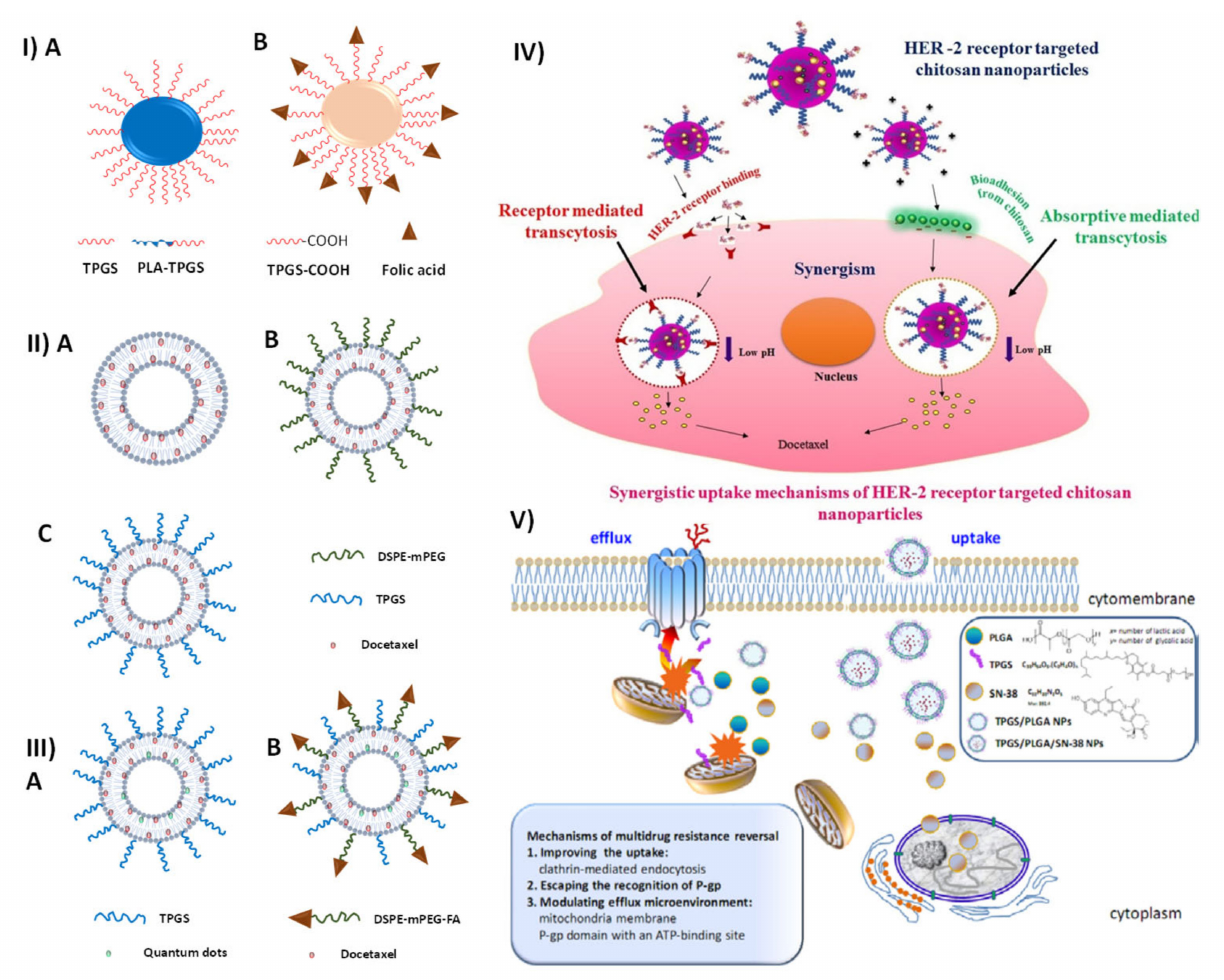
Figure 4. ( I ) ( A ) TPGS-emulsified PLA-TPGS-NPs without a specific target; ( B ) Folate-targeted PLA- TPGS nanoparticle emulsion; ( II ) ( A ) Traditional liposomes, ( B ) Liposomal PEGylation ( C ) Covered lipid vesicles containing TPGS; ( III ) ( A ) nonspecific multipurpose liposomes, ( B ) Liposomes with several targets, including the folate receptor; ( IV ) TPGS-g-chitosan nanoparticles coated with trastuzumab for selective breast cancer therapy; ( V ) Schematic depiction of the novel NPs reversing MDR processes in cancer cells, together with the chemical structures of PLGA, TPGS, and SN-38. ( IV ) Reproduced with permission from Ref. [66], Graphical abstract. (Elsevier 2019). ( V ) Reproduced with permission from Ref. [81], Figure 1 (IOP